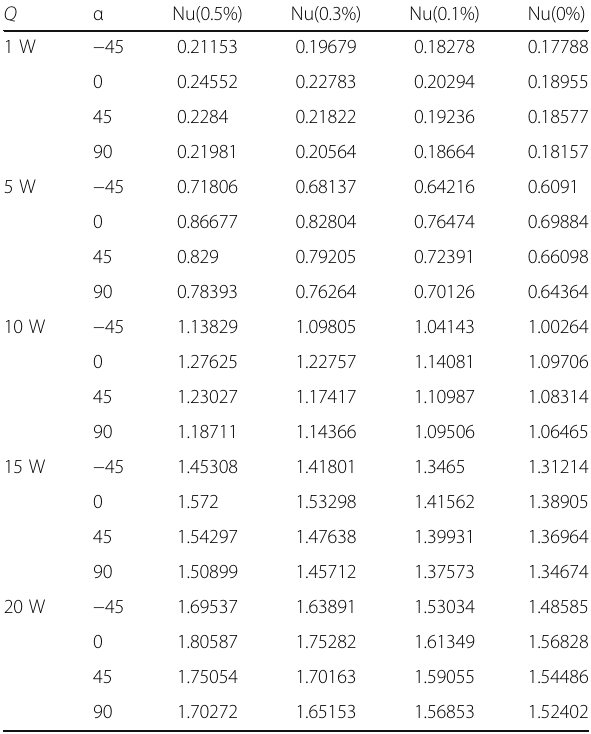
Table 3 Nusselt numbers ( A = 1:2). Nusselt number values based on Fig. 14 ( A =